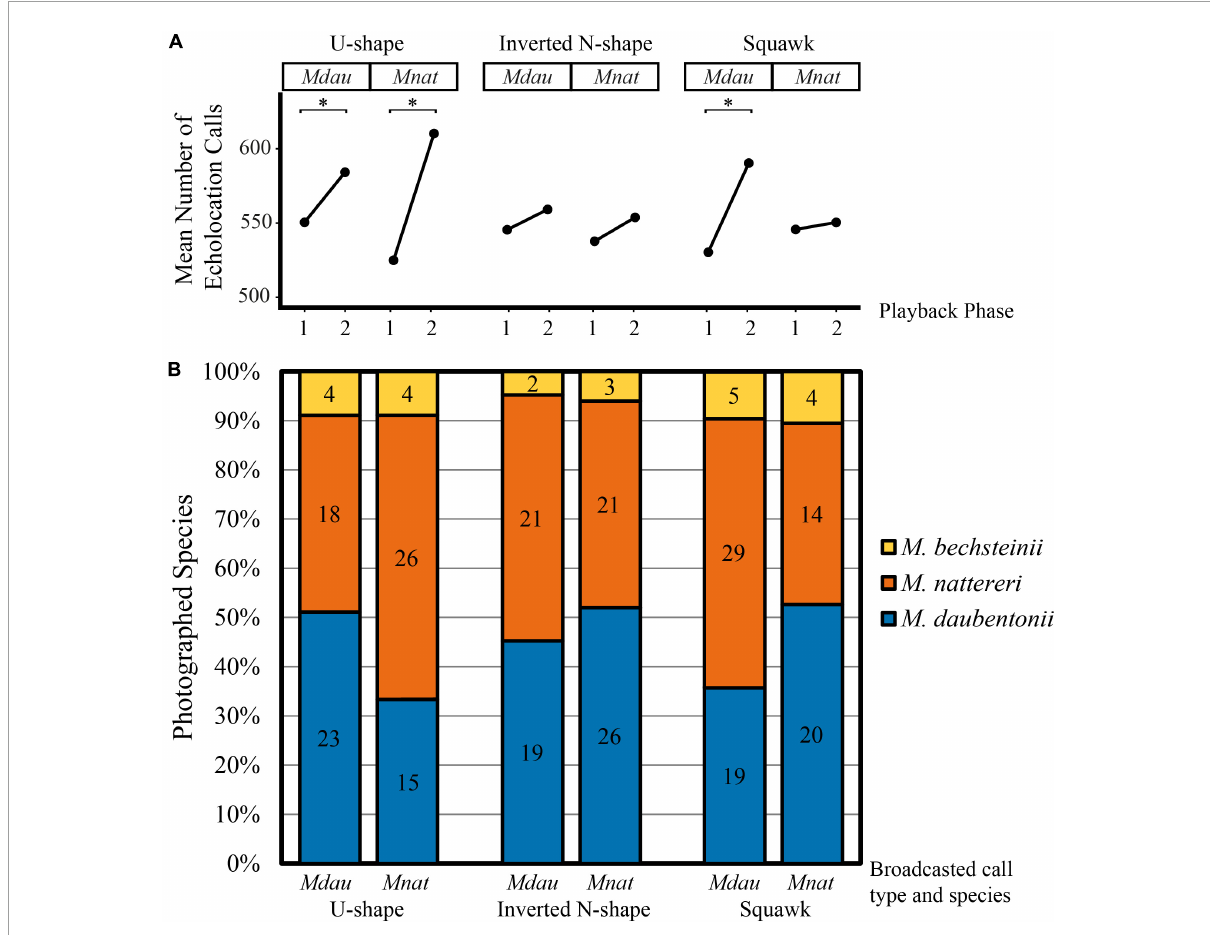
FIGURE6 (A) Mean number of echolocation pulses recorded during the playbacks: Phase 1 is the pre-playback phase, phase 2 is the mean from playback and post-playback phase. When U-shaped calls of both species, respectively, and squawks of Myotis daubentonii were broadcasted, the mean number of echolocation pulses increased significantly ( ∗ marked by an asterisk, Binomial test). (B) Numbers and proportions of visually identified bat species approaching the speaker during playbacks of the different social call types. Species were identified from photos taken during playback and post-observation phase. Mdau, Myotis daubentonii ; Mnat, Myotis nattereri .